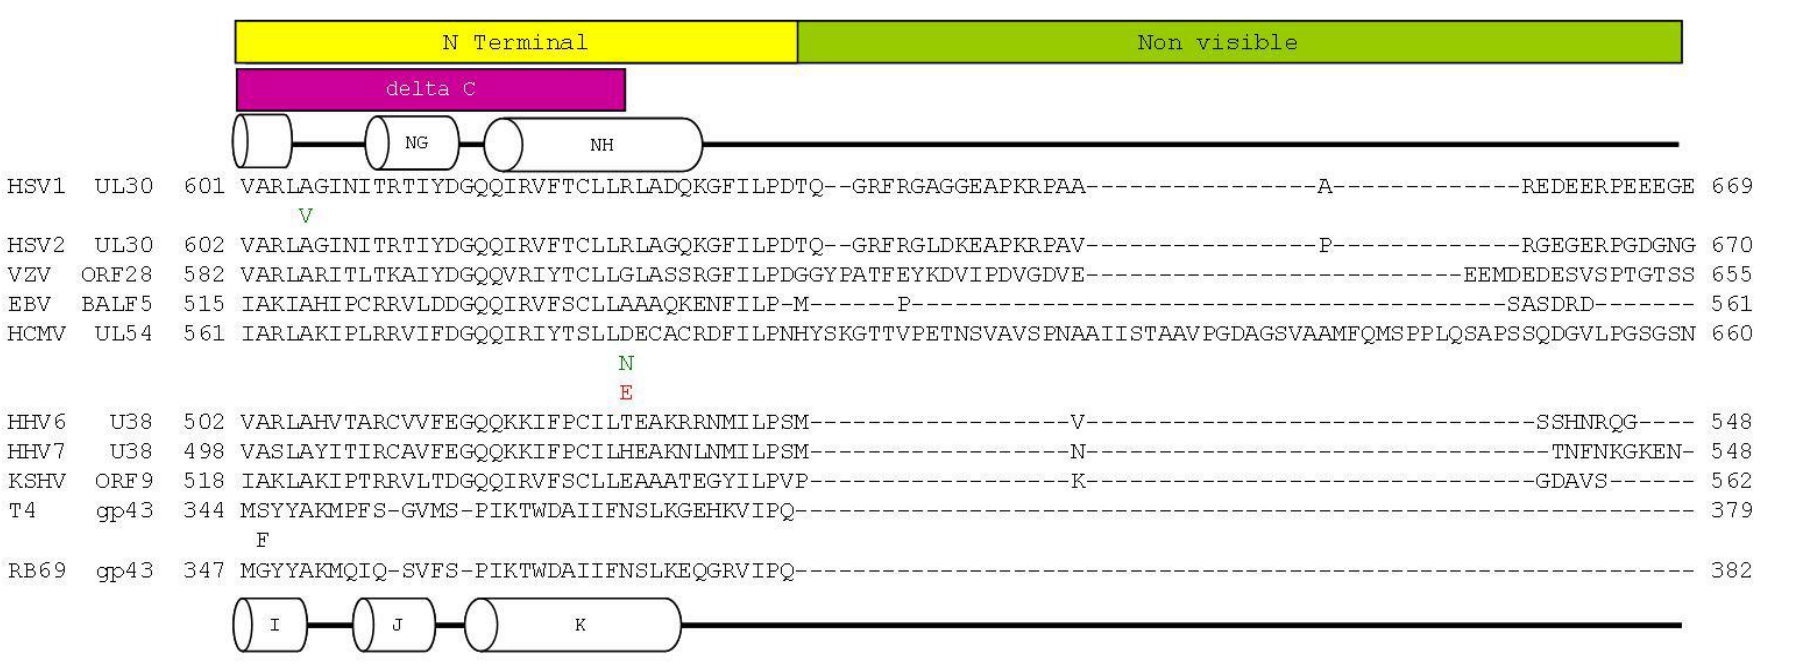
Appendix Figure A1.